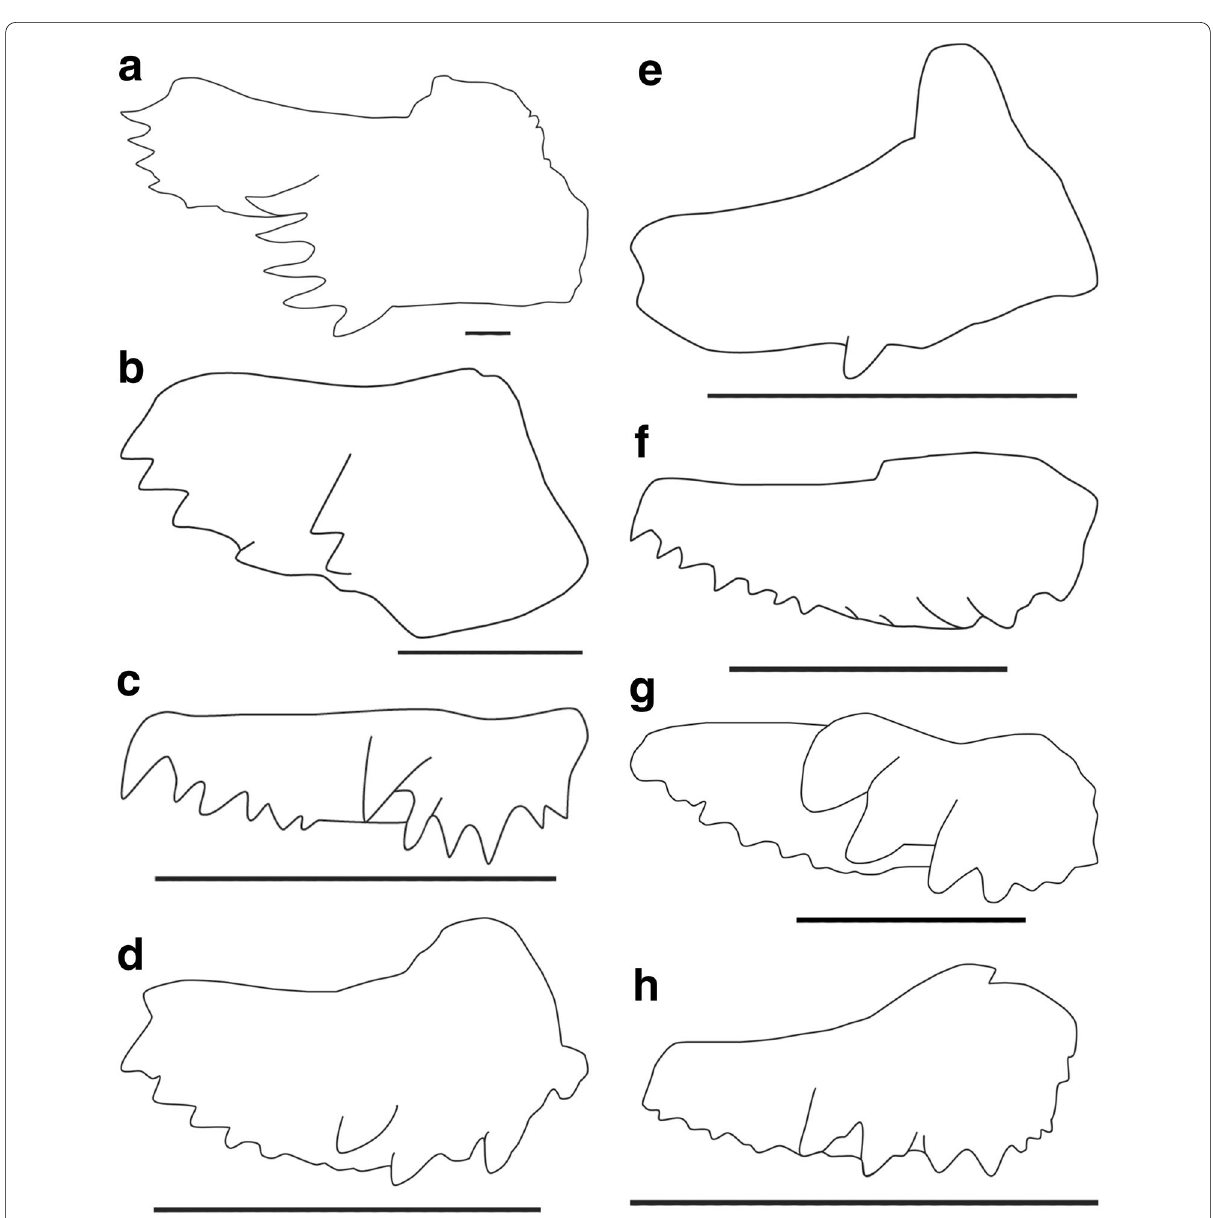
Fig. 5 Line drawings of labial views of eubrachythoracid posterior superognathals. Note the great differences in dimensions. a L. ziregensis. b Plourdosteus canadensis. c Coccosteus cuspidatus. d Harrytoombsia elegans e Mcnamaraspis kaprios. f Eastmanosteus calliaspis. g Torosteus pulchellus. h Compagopiscis croucheri . All scale bars equal 10